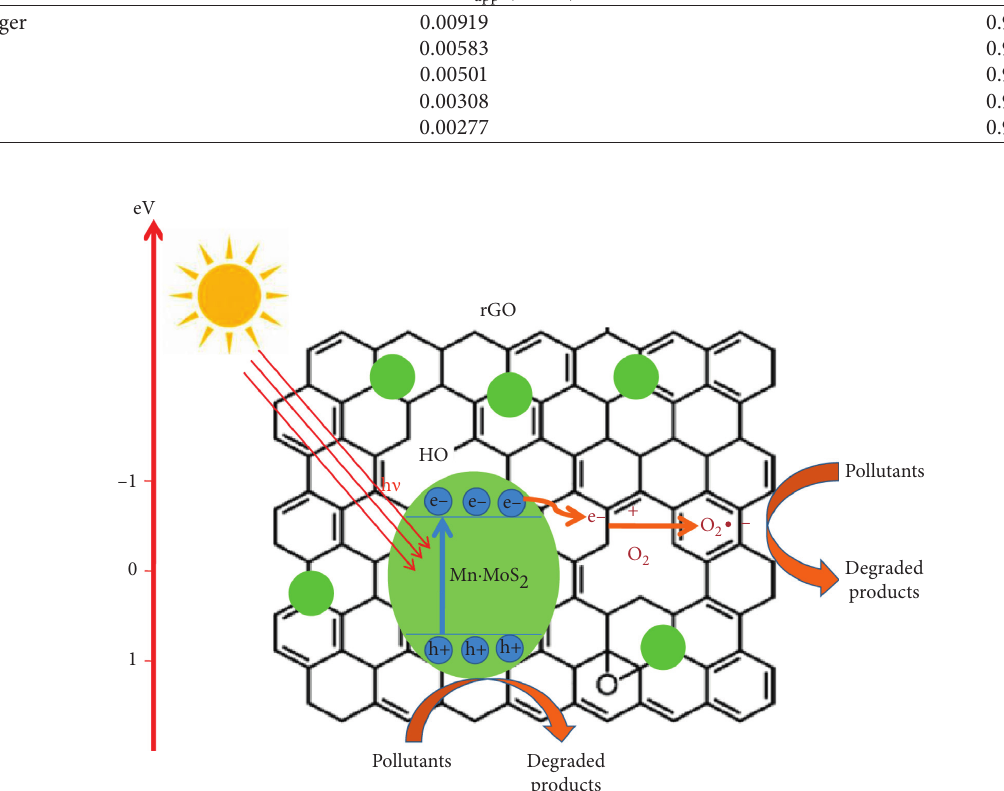
Figure 5: Proposed mechanism for the photocatalytic degradation of RhB over n